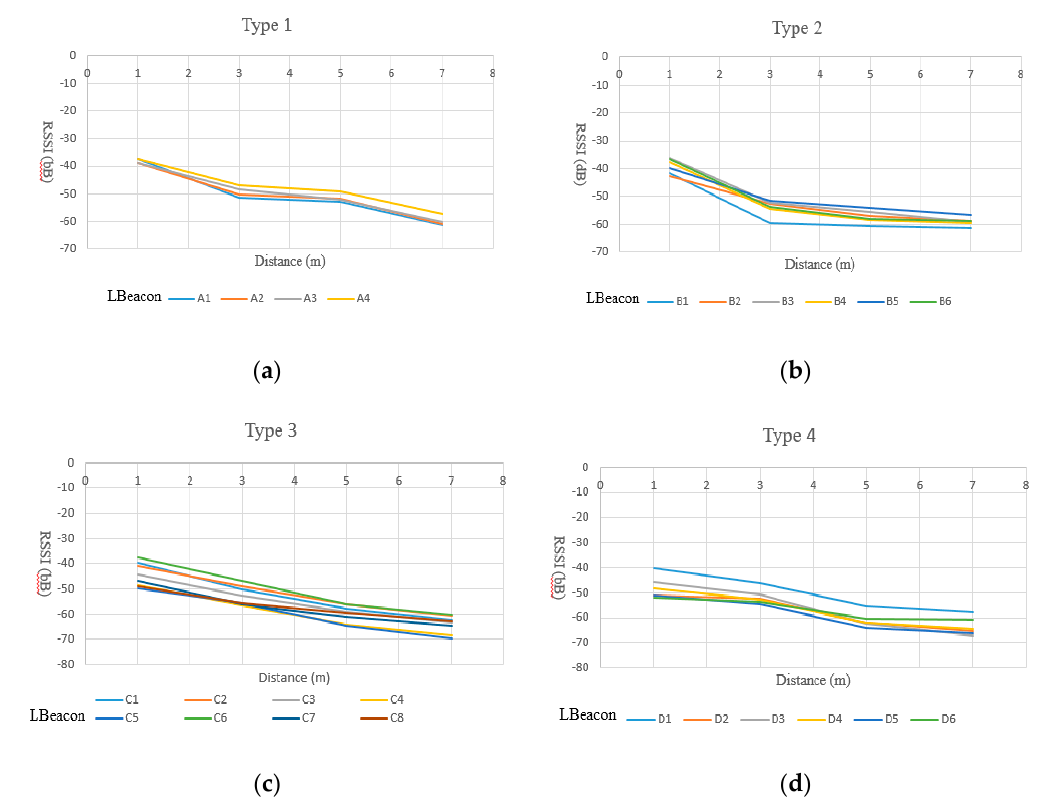
Figure 5. Four types of RSSI distance models. ( a ) Type 1; ( b ) Type 2; ( c ) Type 3; ( d ) Type 4.